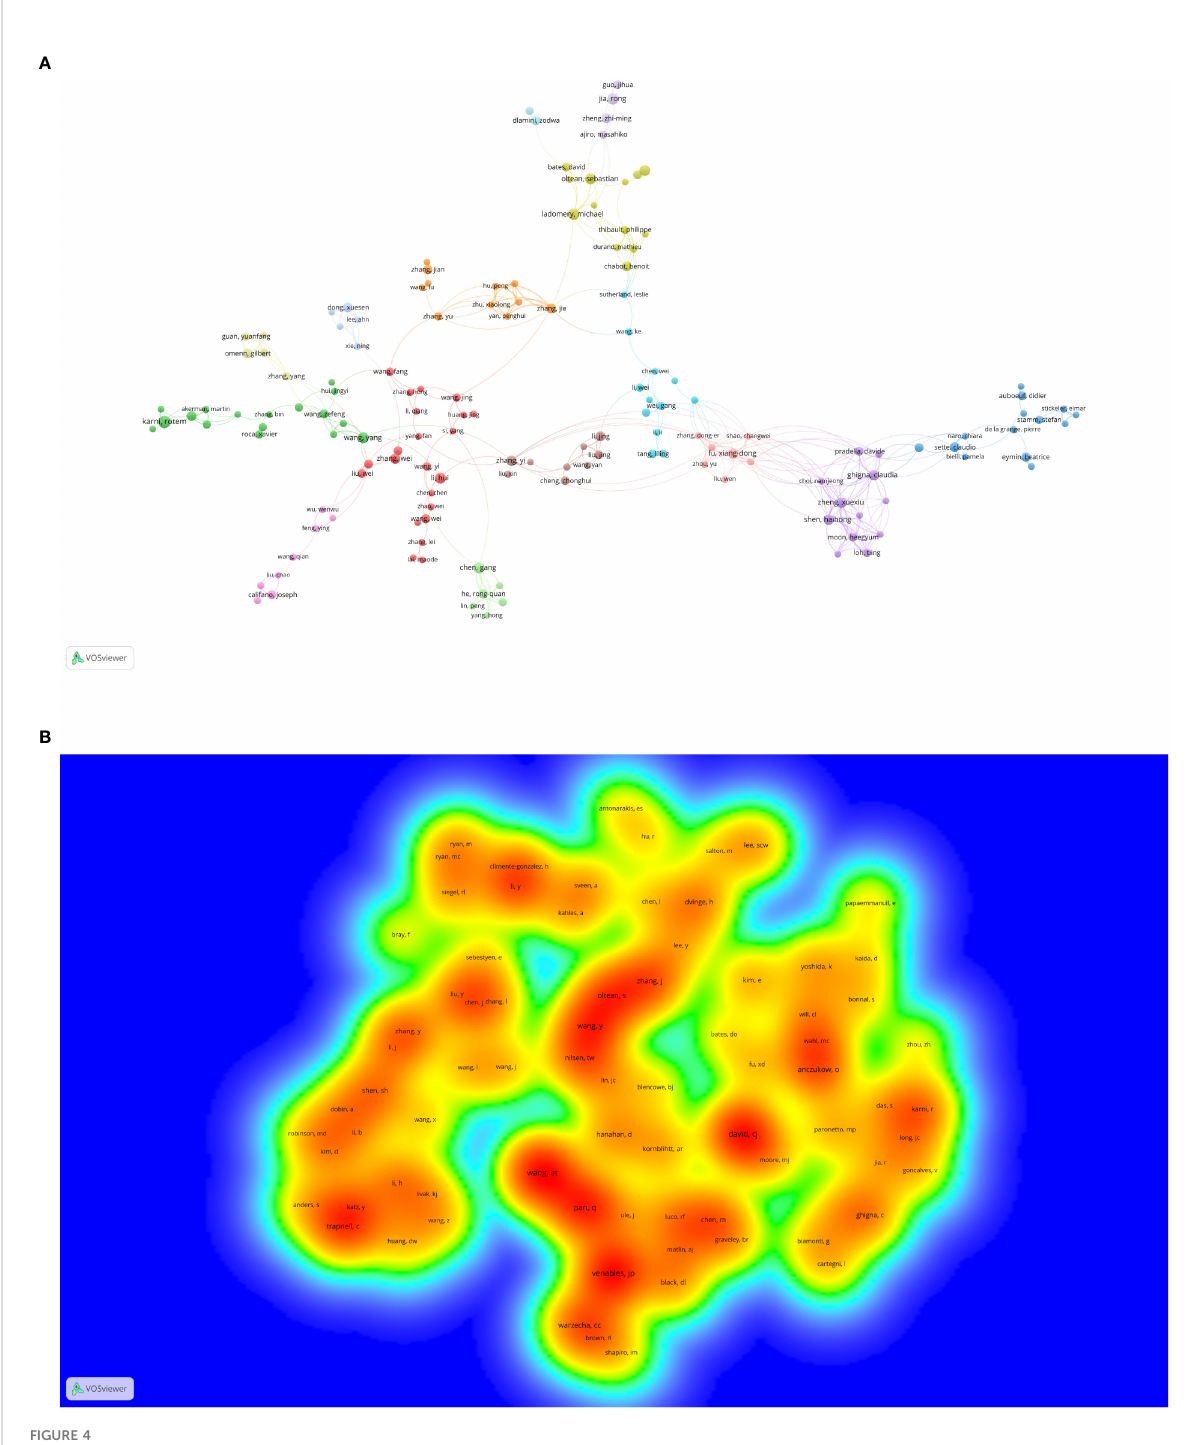
FIGURE 4 The co-occurrence (A) authors ’ (documents ≥ 5) cluster map and (B) co-cited authors ’ (citations ≥ 100) density map of alternative splicing of cancer research. (A) Nodes with the same color represent that they belong to the same cluster, the size of the node is proportional to the number of articles published by the author, and the thickness of the connection is proportional to the number of articles co-published by two authors. (B) The co-cited frequency is positively correlated with the size and depth of the word and the yellow color,